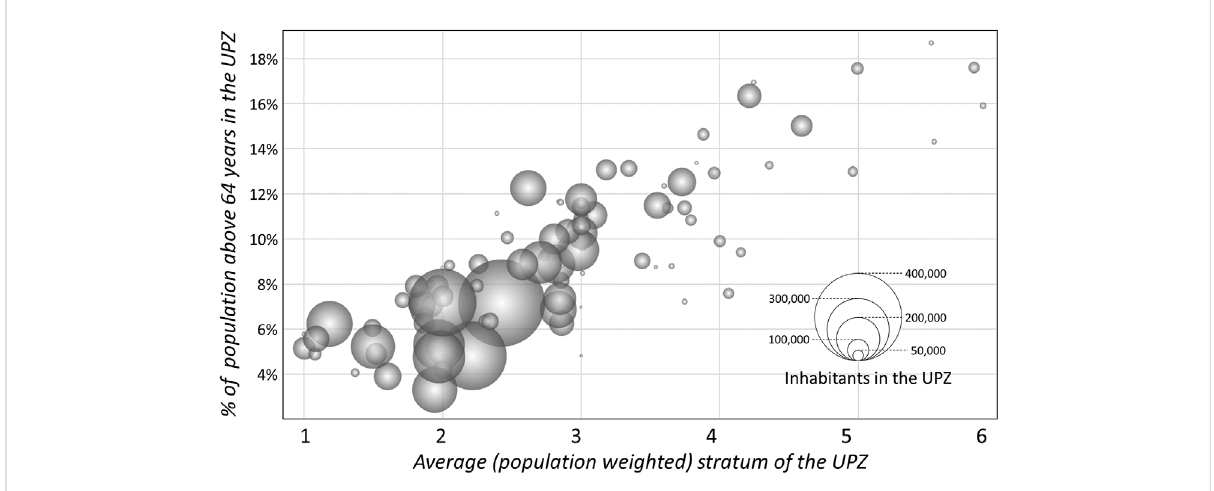
FIGURE 14 Scatter plot of the average stratum of the UPZ (horizontal axis) versus the percentage of adults older than 64 years in the